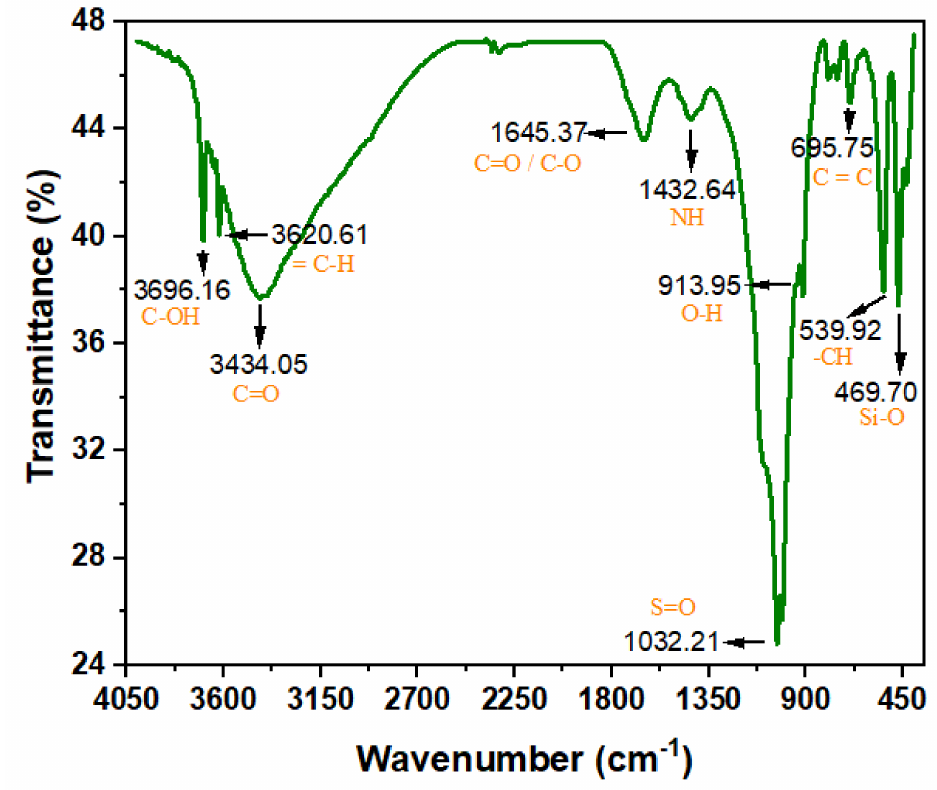
Figure 2. FTIR spectra of